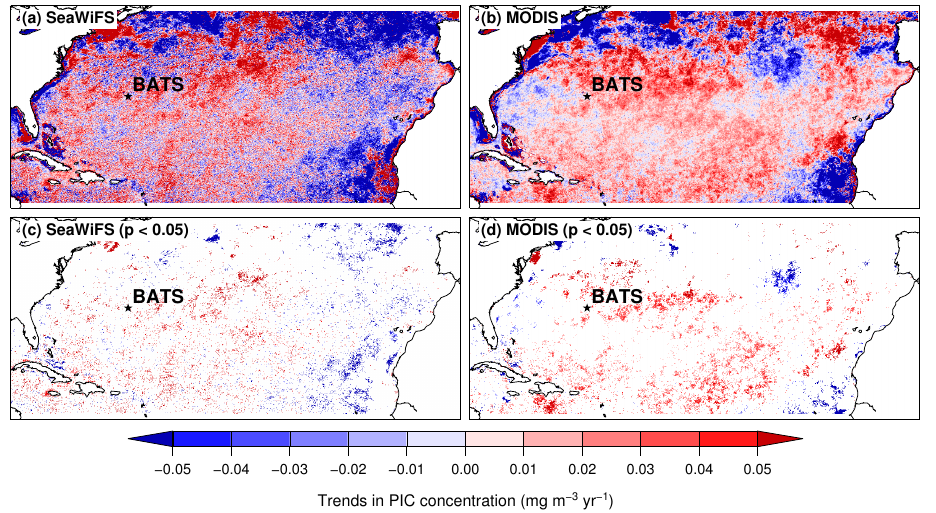
Figure 8. Trends in PIC concentration derived from satellite data for (a, c) SeaWiFS (1998–2007), and (b, d) MODIS (2003–2014). Bottom panels shows significant trends ( p < 0 . 05).